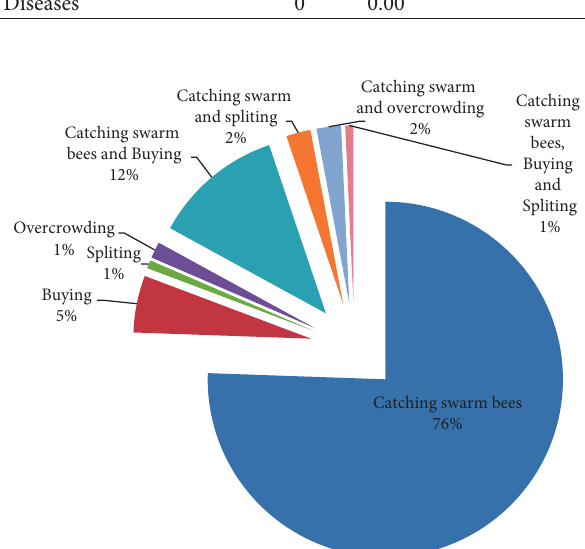
Figure 2: Methods of increasing bee colony in the study areas.